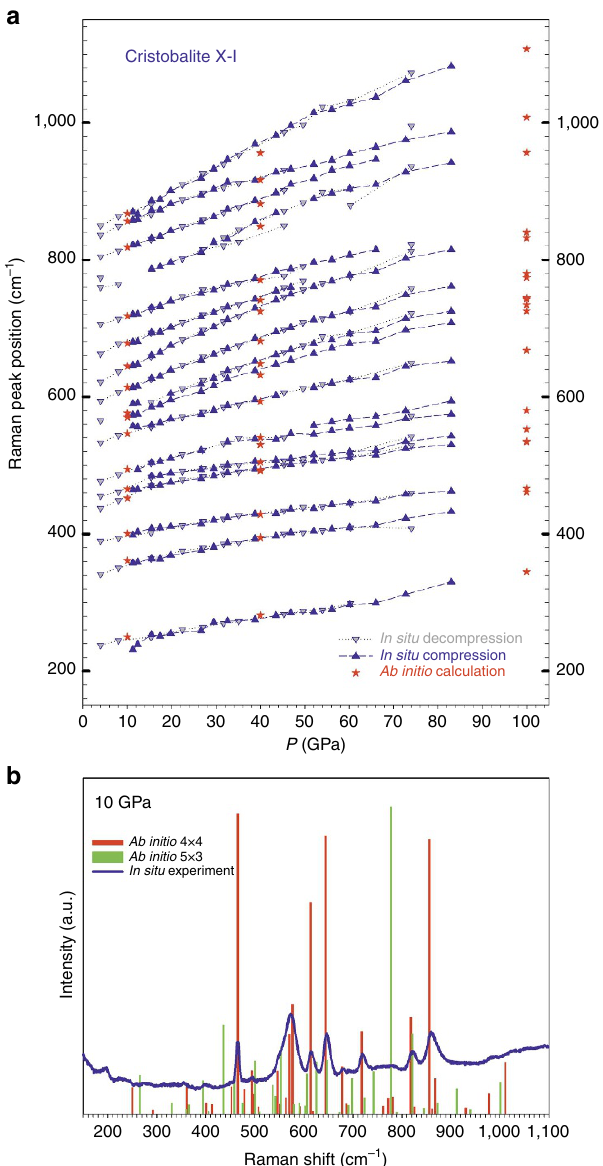
Figure 3 | Pressure Raman spectra of cristobalite X-I. ( a ) Pressure dependence of the Raman modes in cristobalite X-I at ambient temperature obtained experimentally (blue triangles ‘up’ for compression and ‘down’ for decompression) and simulated by ab initio calculations for the 4 (cid:2) 4 arrangement (red stars). The lines are guides for enhanced readability. ( b ) Comparison of the Raman experimental spectrum (blue continuous line) and theoretical spectra for the 4 (cid:2) 4 (red vertical bars) and 5 (cid:2) 3 (green vertical bars) arrangements at